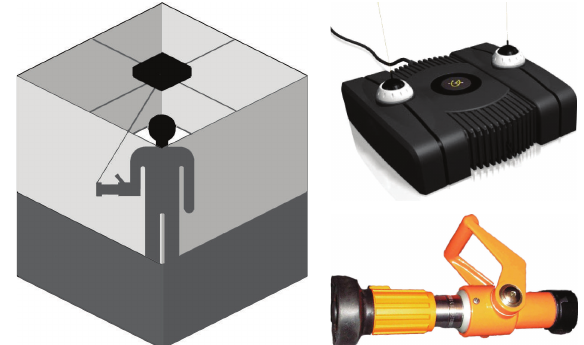
Figure 2: The string of the GameTrak (top right) is attached to the fogfighter nozzle (bottom right). N.B., only one of the GameTrak’s [25] two controls is